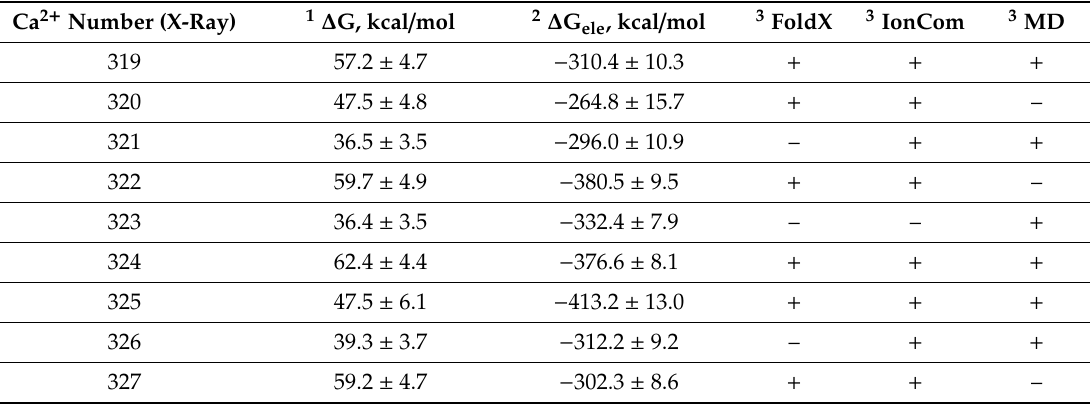
Table 7. MM-GBSA free energy calculations (per Ca 2 + ion) for the experimentally known Ca 2 + binding sites in annexin